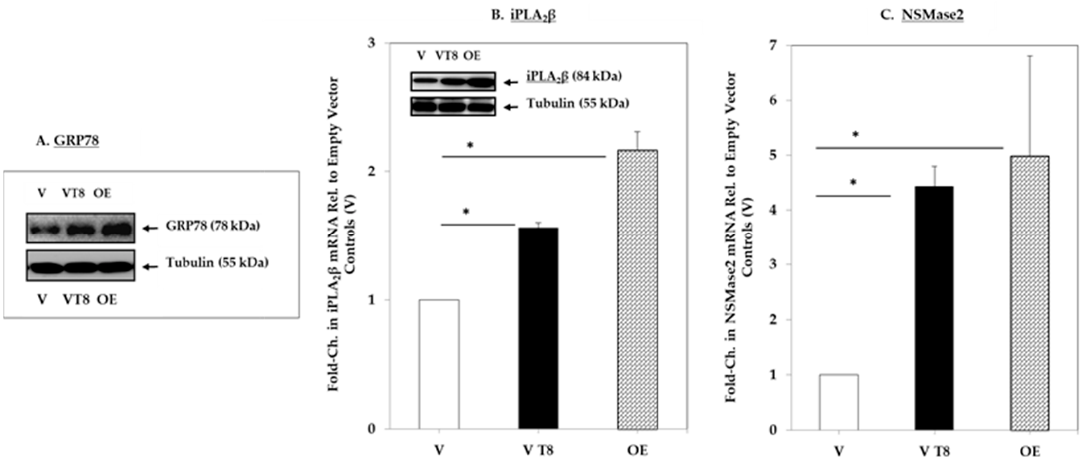
Figure 1. GRP78, iPLA 2 β , and NSMase2 expression in INS-1 cells in the absence and presence of thapsigargin (T). Protein and cDNA were prepared from empty vector (V) INS-1 cells treated with DMSO (V) or thapsigargin (1 µ M for 8 h (VT8)) and iPLA 2 β -overexpressing (OE) INS-1 cells for immunoblotting and RT-qPCR analyses, respectively. Tubulin was used as a loading control in the protein analyses. ( A , B ). RT-qPCRs: 18S served as internal control, and fold-change in mRNA was calculated using the delta C T method ( ∆ C T ) and expressed relative to V controls: ( A ) ER stress marker GRP78, ( B ) iPLA 2 β mRNA ( inset , iPLA 2 β protein); and ( C ) NSMase2 mRNA. Data are presented as mean ± SEM, n = 3 per group. (* Significantly different from V control, p < 0.05.).